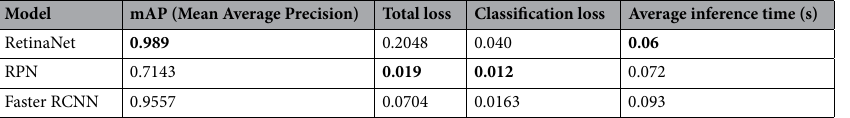
Table 2. Comparison of mean average precision, losses, and average inference time of different models on the fluorescence image dataset.